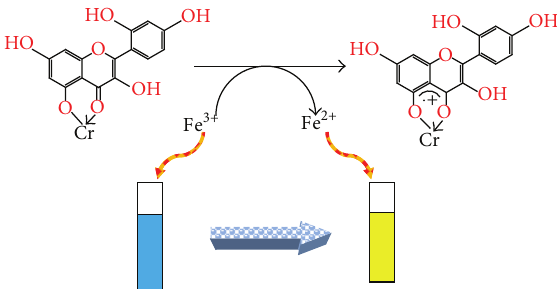
Scheme 3: The mechanism shows that the blue color of the antioxidant samples (the reduced product leading to the formation of intense Perl’s Prussian blue Fe 4 [Fe(CN) 6 ] 3 complex which is reduced to Fe 2+ ) may change into yellow color upon addition of free Fe 3+ ions (as illustrated through